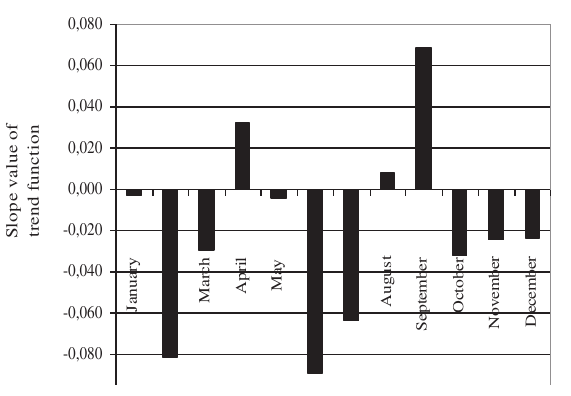
Figure 12 – The spatial distribution of mean daily slope values of the trend-function expressing the changes of the absolute daily maxima of precipitation in summer according to data raised at 16 stations over 1951–2010